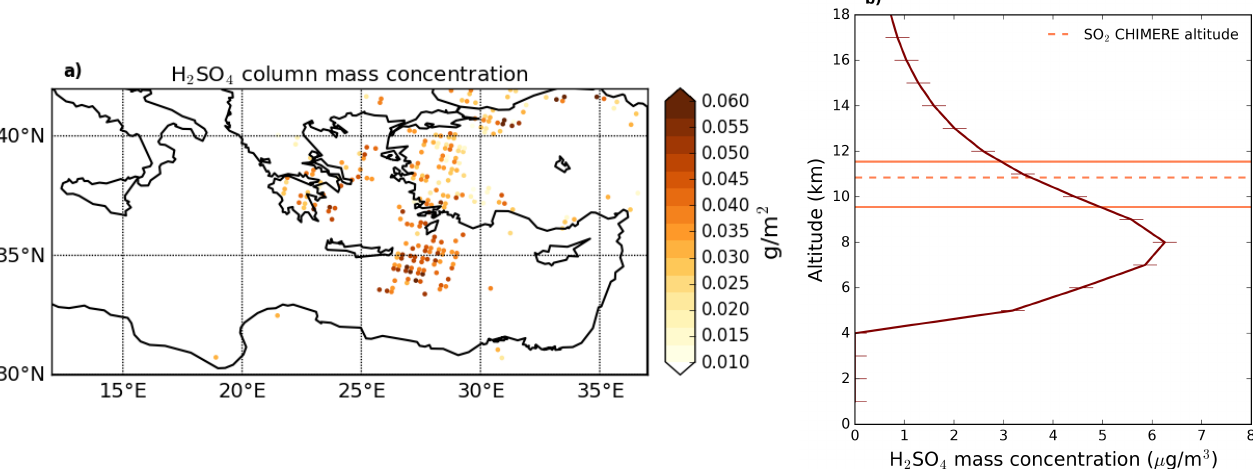
Figure 7. ( a ) AEROIASI-H2SO4 mass column concentration for IASI daytime overpass on 19 March 2012; ( b ) average vertical profile of AEROIASI-H2SO4 mass concentration for the eastern section of the plume region. Horizontal lines represent the average altitude of the maximum in the SO 2 profiles for volcanic-only CHIMERE run, with its standard deviation, in the same plume